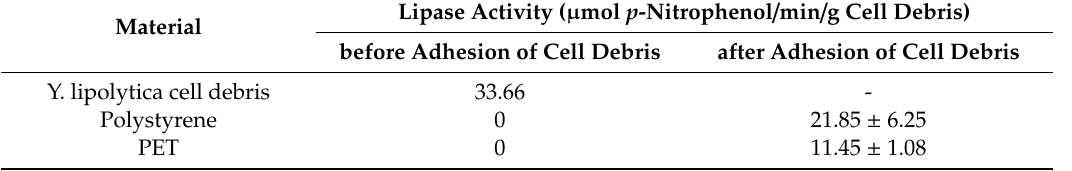
Table 5. Hydrolysis of p -nitrophenyl laurate by Y. lipolytica IMUFRJ cell debris and Y. lipolytica IMUFRJ cell debris adherent to polystyrene and